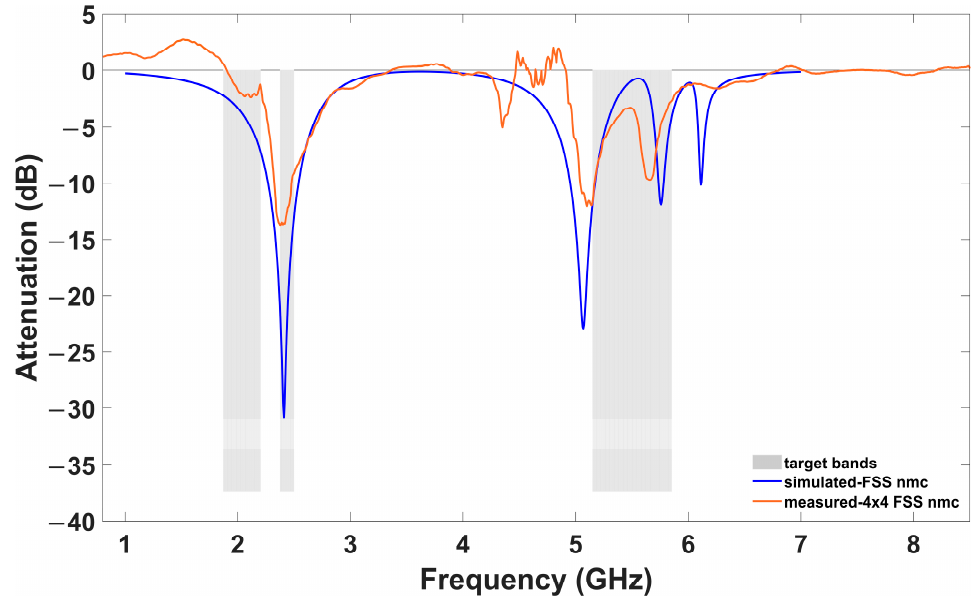
Figure 8. Simulated effect of increasing inter-element spacing ( d ) under Floquet mode boundary con- ditions.